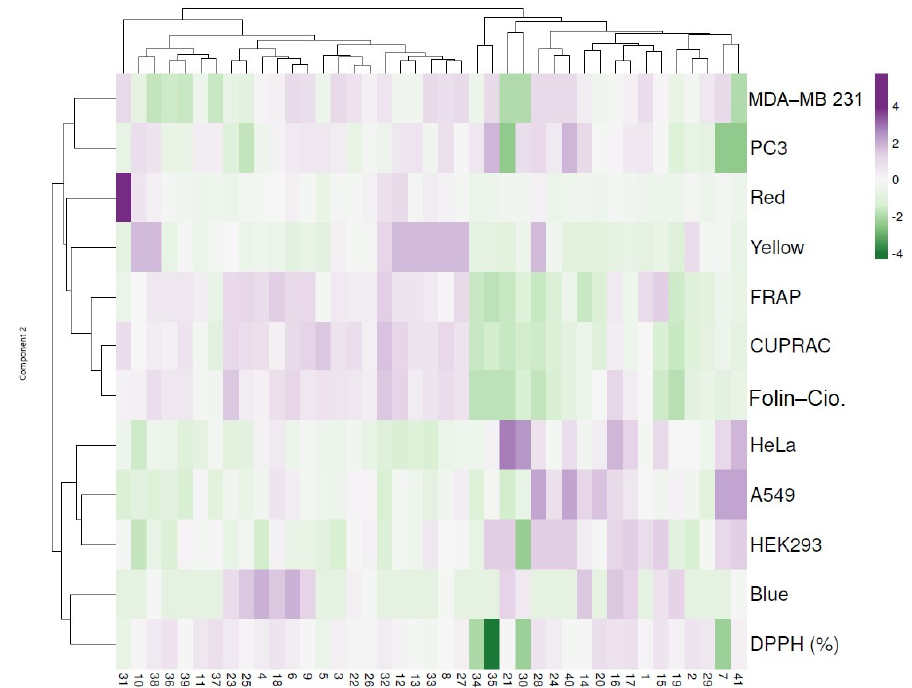
Figure 4. Hierarchical clustering and heat map visualization of the 41 propolis samples based on their color, antioxidant activity and cytotoxicity. Columns indicate the propolis samples and rows the color index, antioxidant activity and cytotoxic assays. Cells are colored based on the quantity in each propolis sample, where purple represents a strong positive correlation and green a strongly negative correlation. The row dendrogram resulted from the correlation between the color index, antioxidant activity and cytotoxic assays; the column dendrogram showed the correlation between propolis samples.